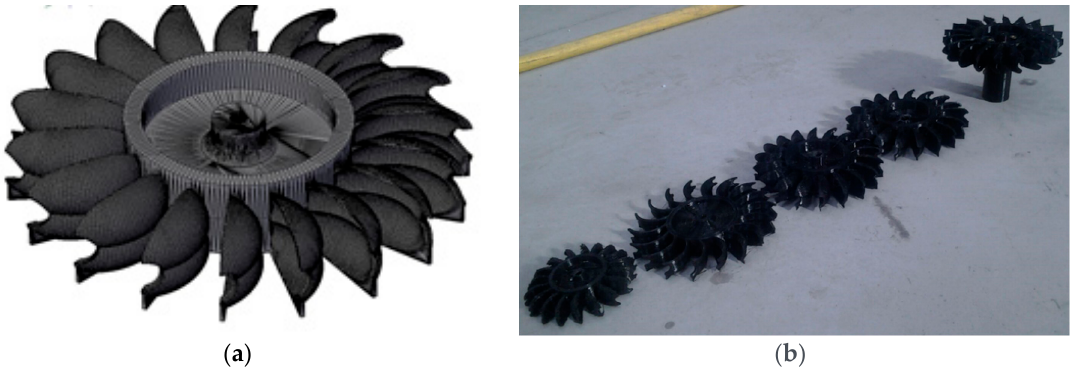
Figure 5. ( a ) Axonometric 3D view of the microturbine in the CAD environment. ( b ) Printed PLA